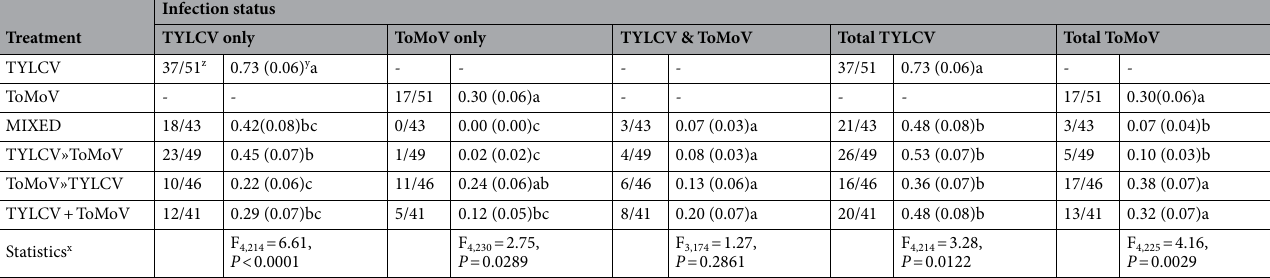
Table 4. The average proportion of vector inoculated plants systemically infected with TYLCV or/and ToMoV. LS means comparisons among treatments were conducted using Tukey’s method at P = 0.05 level to compare infection of viruses singly (TYLCV only, ToMoV only columns), together (TYLCV & ToMoV column), and sum of virus infection (Total TYLCV, Total ToMoV columns). z Total number of samples testing